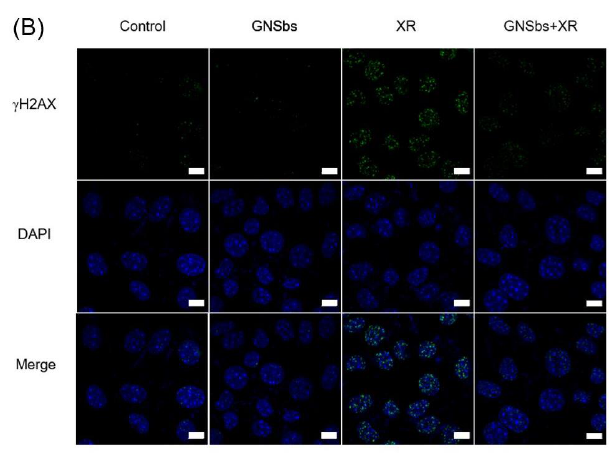
Figure 6. The fluorescence images of DNA damage in ( A ) CAL-27 and ( B ) L929 cells treated with or without GNSbs (75 µ g mL − 1 ) under radiation (0 and 2 Gy). The blue and green fluorescence signals represent cell nucleus (DAPI) and DNA double-strand breaks ( γ -H2AX), respectively. Scale bar = 10 nm.